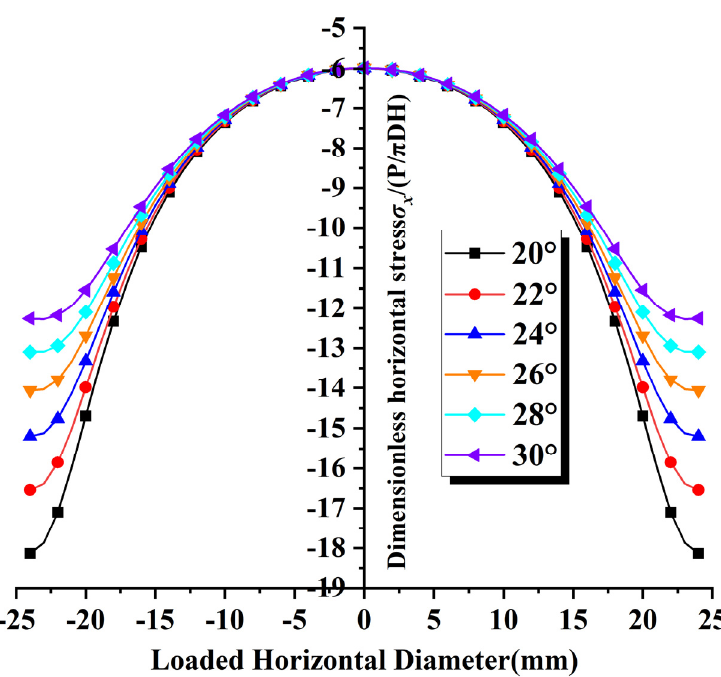
Figure 6. Non-dimensional horizontal stresses along loaded diameter. Table 2. Ratios of non-dimensional compressive stress to tensile stress inside discs. Loading Angle ( ◦